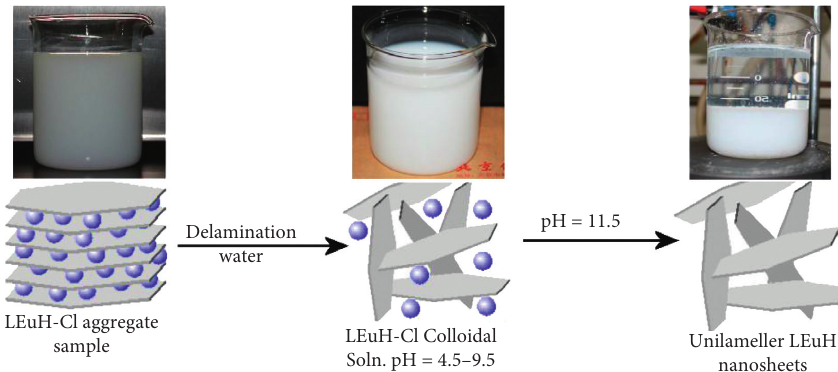
Figure 1: The flocculation process generating LEuH-flocs nanosheets through pH